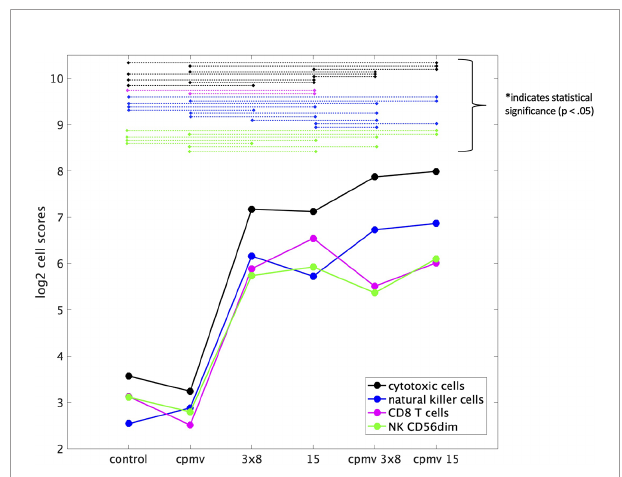
FIGURE 4 | Immune Cell Abundances (mRNA). Cell type scores calculated using reference genes speci fi c to certain cell types, for a variety of immune cell populations versus treatment cohorts. These scores (in the log 2 space) represent cell abundance and allow for comparison of abundance across various treatments. Both cytotoxic and natural killer cells appear to have an increase of about 1 on the cell type score from 15 Gy to Cowpea mosaic virus (CPMV)/15 Gy indicating a two-fold increase in these cell populations. There is also an increase from 3x8 Gy to CPMV/3x8 Gy, but it is not as large as that between the 15 Gy cohorts. Statistical signi fi cance between groups is indicated by the dashed lines connecting the two treatment groups, as labeled.